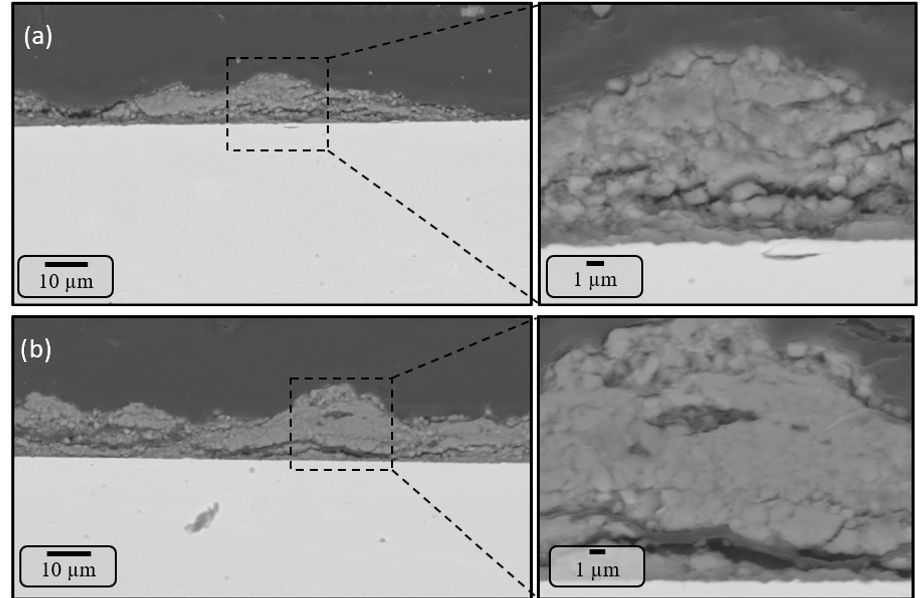
Figure 6. SEM images from the cross ‐ section of BHAp coatings obtained at 10 mm—300 °C—5bar ‐ one spraying pass ( a ) with the conventional nozzle, ( b ) with the modified nozzle.